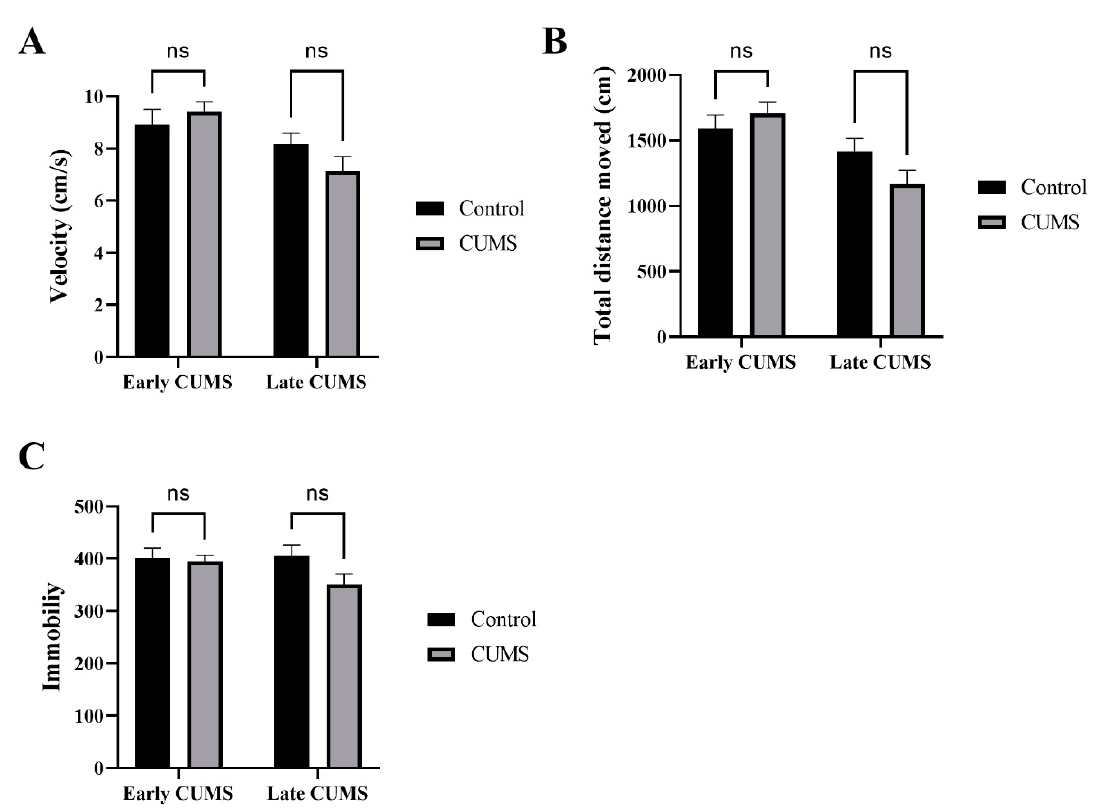
Figure 3. The effect of early and late CUMS on locomotor activity in the OFT. ( A ) Velocity (cm/s); ( B ) total distance moved (cm); ( C ) immobility frequency. Two-way ANOVA was used, followed by Šídák’s multiple-comparisons test. OFT: open field test; ns: not significant.